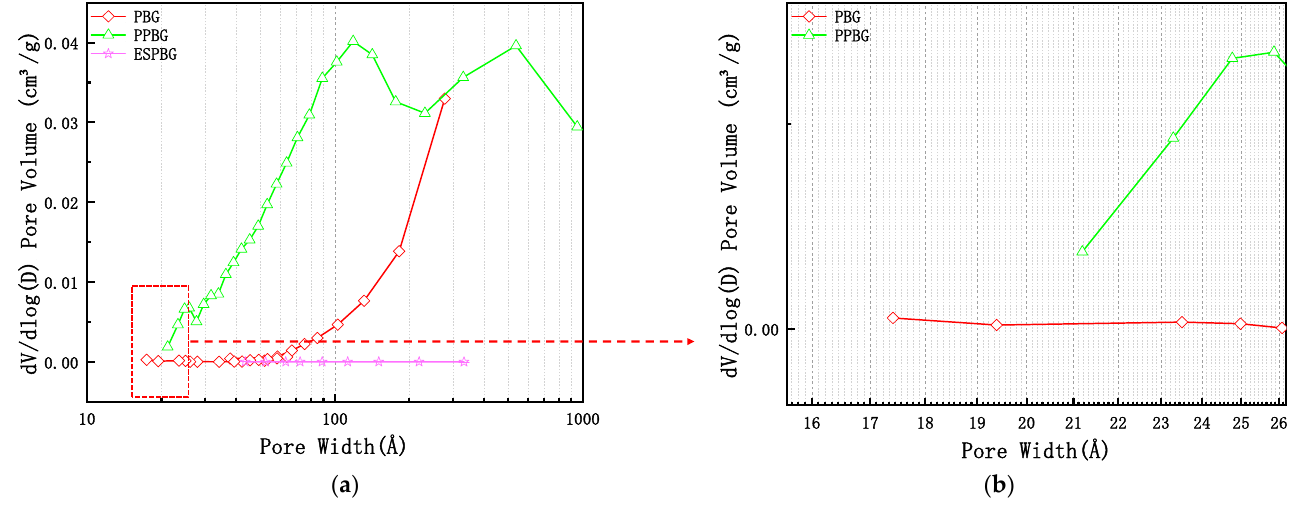
Figure 11. Pore size distribution of the PBG, PPBG, and ESPBG. Figure 11a,b show that the pore size distributions of the PBG, PPBG, and ESPBG were 1.74–27.71 nm (1 Å = 0.1 nm), 2.19–100 nm, and 4.35–33.2 nm, respectively. The results in Figure 11a,b show that the cumulative pore volumes of the PBG, PPBG, and ESPBG in the pore diameter range of 0–1000 nm were between 0 and 0.022 cm³/g, 0 and 0.042 cm³/g, and 0 and 0.0019 cm³/g, respectively. The results in Figure 12a,b illustrate that the PBG was mainly mesoporous, with fewer micropores and macropores.